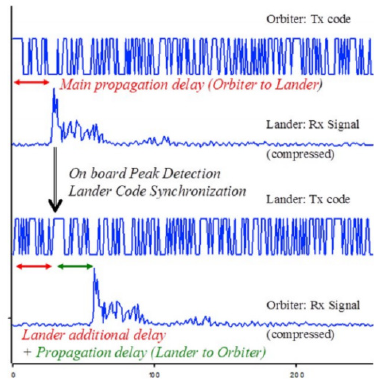
Figure A2. The CONSERT “ping-pong” signal propagation scheme (from [27]).